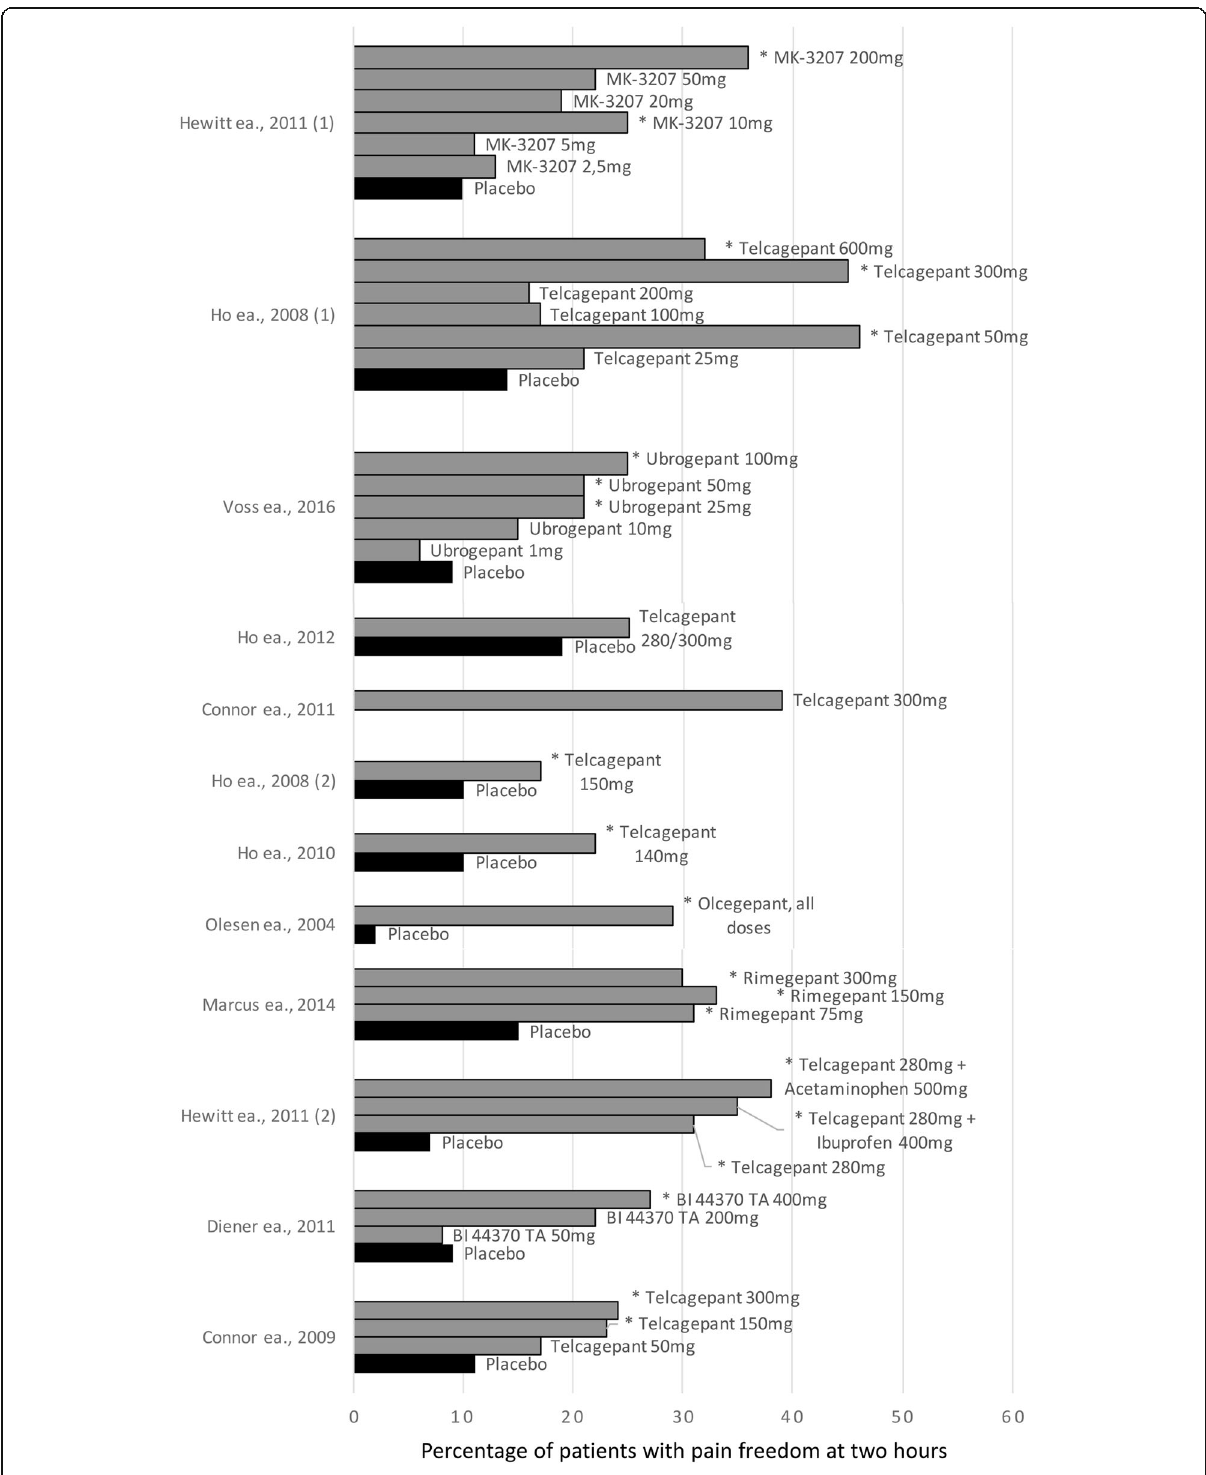
Fig. 1 Efficacy of gepants in the acute treatment of migraine. Bars indicated with * represents statistically significant values compared to placebo ( p <